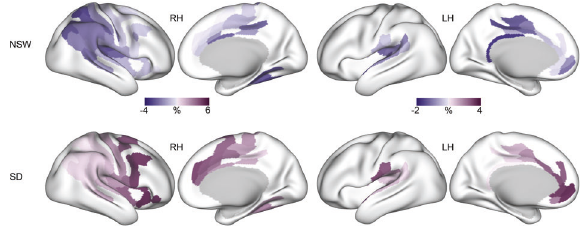
Fig. 3 Regional variation in sensitivity to either normal sleep- wake (NSW) or sleep deprivation in the right hemisphere (RH, left side) and left hemisphere (LH, right side). Percentage change within each signi fi cant cluster for the NSW group (top) and sleep deprivation group